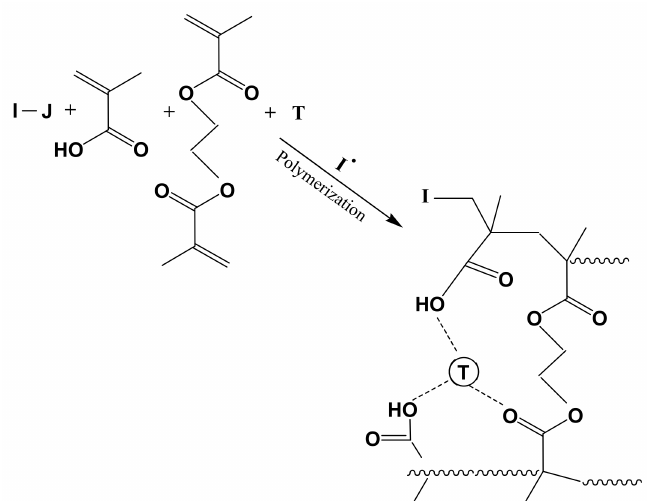
Figure 3. Simplified mechanism of imprinted vinylic polymer synthesis by radical polymerization. Example is given for methacrylic acid functional monomer and ethylene glycol dimethacrylate (EGDMA) crosslinker. I–J is the initiator and T the